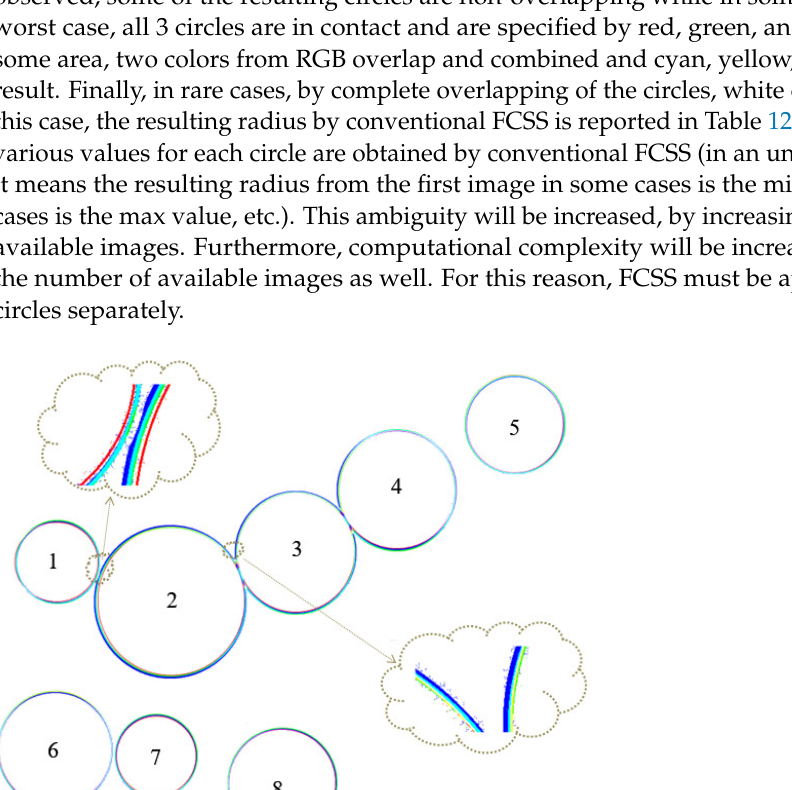
Figure 8. Three georeferenced satellite images (obtained using Google maps) obtained over three different dates ( a ) 23-10-2011 ( b ) 09-09-2016 ( c ) 30-12-2018 (used for state 4).